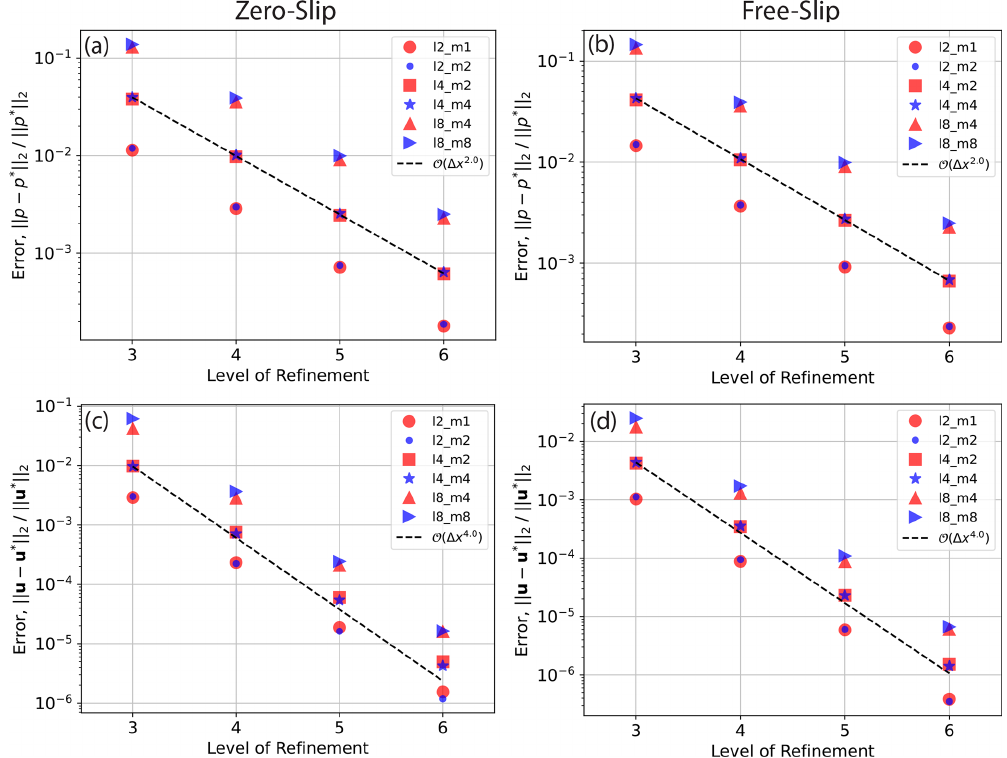
Figure 9. Convergence of velocity and pressure for 3-D spherical shell cases with zero-slip and free-slip boundary conditions for perturba- tions at a range of spherical harmonic degrees l and orders m . Note that all cases with a smooth forcing are run at k = l + 1. Refinement level 3 corresponds to the level specified for our cubed sphere mesh, comprising 386 elements in the tangential direction, which is extruded radially to eight layers. Resolution is doubled in all directions at subsequent refinement